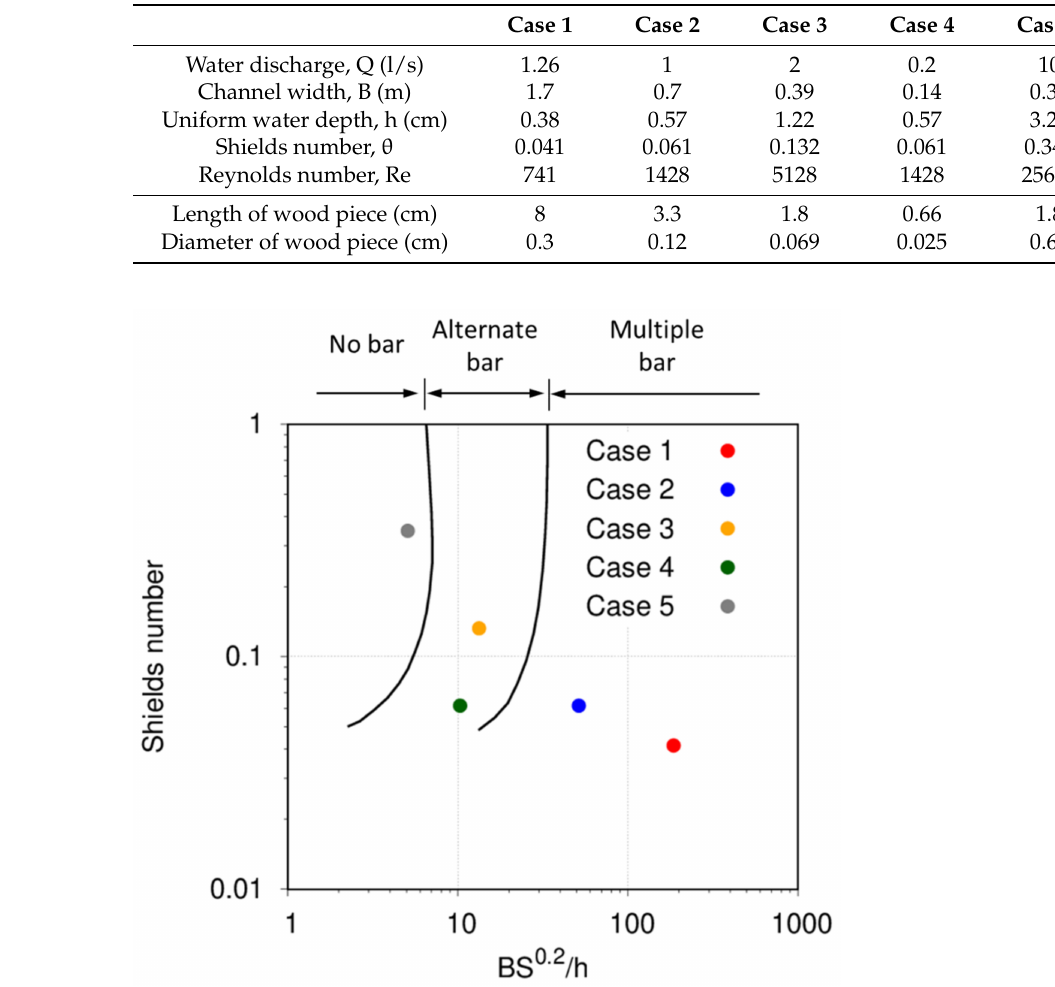
Figure 5. Dominant bar modes in the numerical simulation predicted by bar regime diagram as proposed by Kuroki and Kishi [33]. S denotes channel